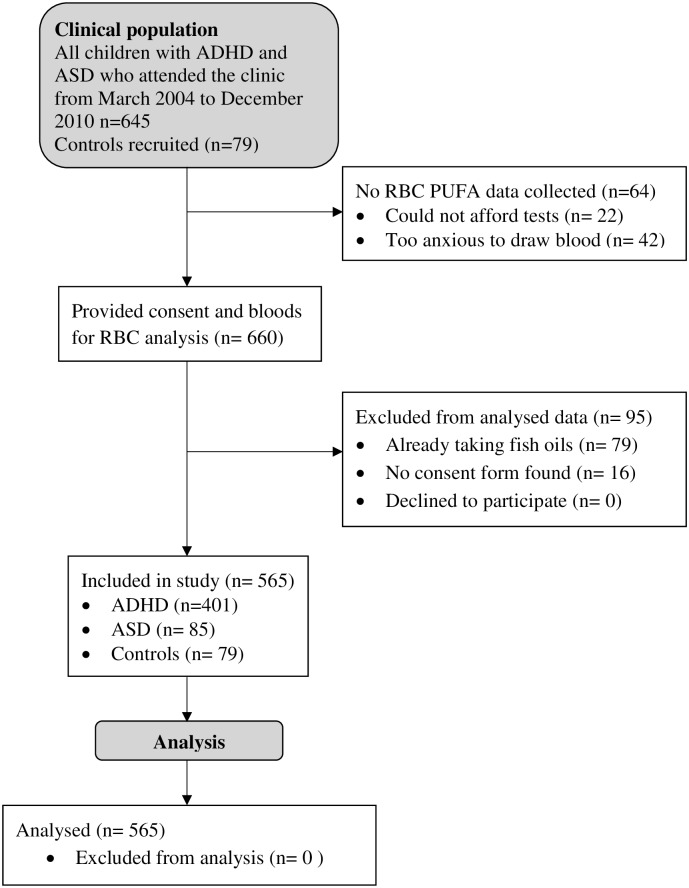
Flow of participants through the study.